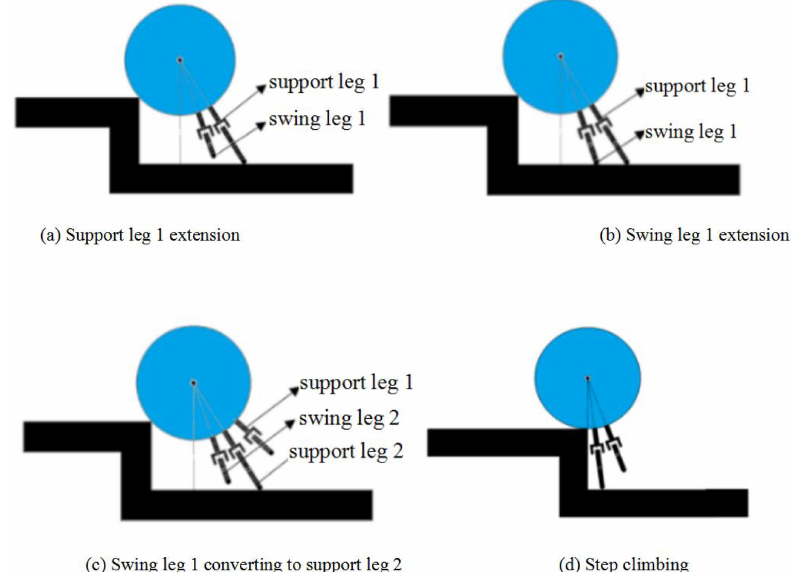
Figure 5. Gait planning of legged obstacle walking.